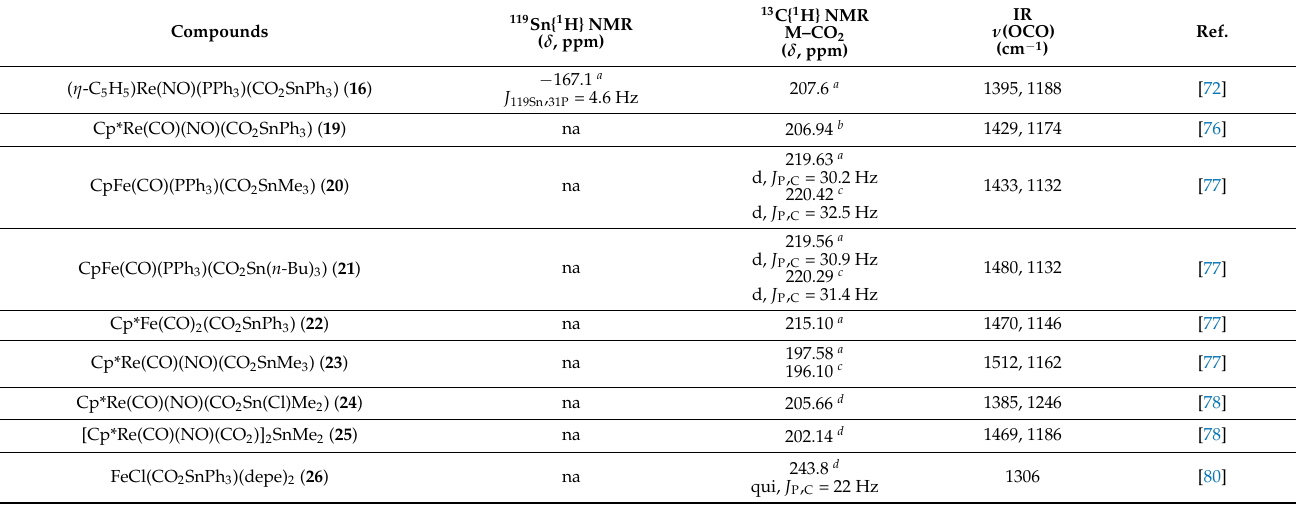
Table 8. Selection of spectroscopic data (NMR and IR) assigned to metallocarboxylato tin complexes.